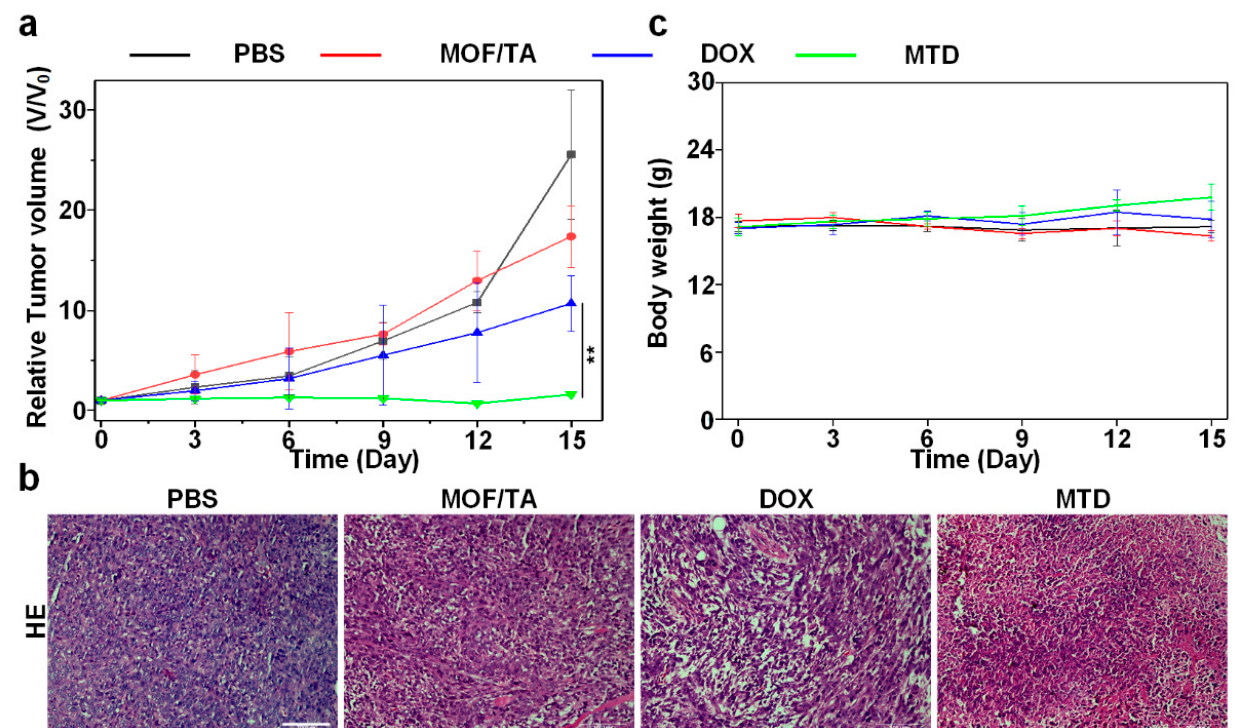
Figure 5. In vivo antitumor effects of MTD: ( a ) relative tumor volume of mice after different treatments; ( b ) H&E analysis of mice tumors collected from different groups. Scale bar, 100 µm; ( c ) body weight of tumor-bearing mice during the treatment period. Data are represented as the arithmetic mean ± SD, and one-way ANOVA followed by Dunnett’s test were performed for statistical analysis (** p < 0.01).